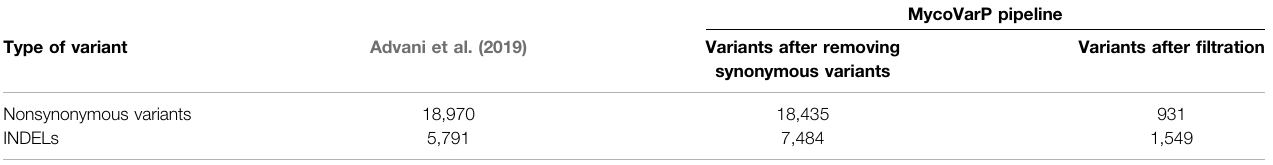
TABLE 1 | Number of variants observed in the published data of Advani et al. (2019) and the MycoVarP pipeline.